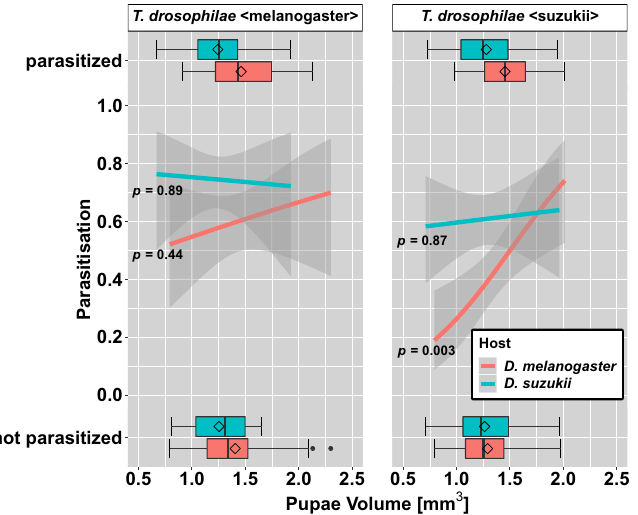
Figure 2. Proportions with a 95% confidence interval of parasitised D. suzukii (blue) and D. melanogaster (red) pupae in relation to pupae volume. The wasp T. drosophilae was reared either on D. melanogaster (left side) or D. suzukii pupae (right side). The variation of the volume of parasitised and not parasitised pupae volume is given in the box plots on top and bottom (for GLMMs see Table S1).